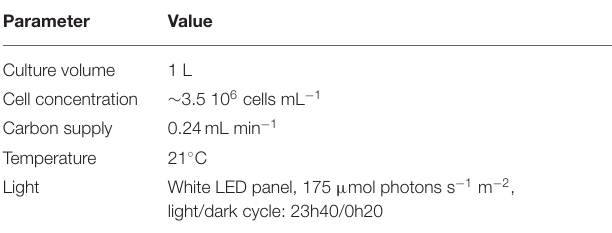
TABLE 1 | Summary of the cultivation